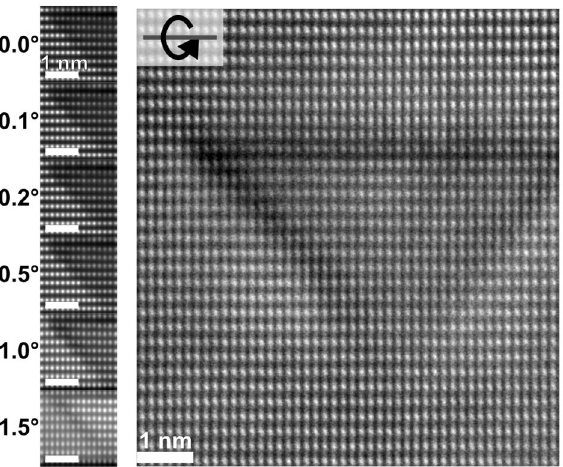
Figure 6. Comparison of acquired HAADF-STEM image (right) to simulated projections with overlap between matrix and PID. The simulated PID has the same Mg-thickness as the model in Fig. 4. The simulations show increasing rotation around the horizontal axis.